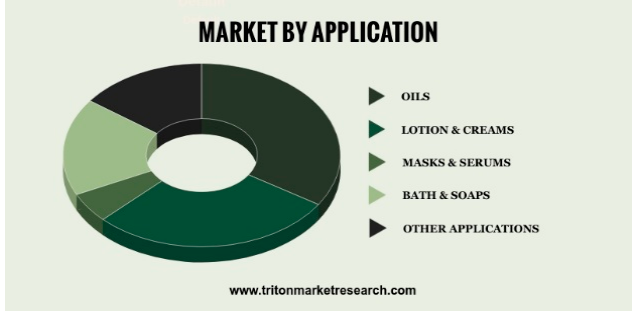
Figure 6. Segmentation of CBD application in the cosmetic sector [20].